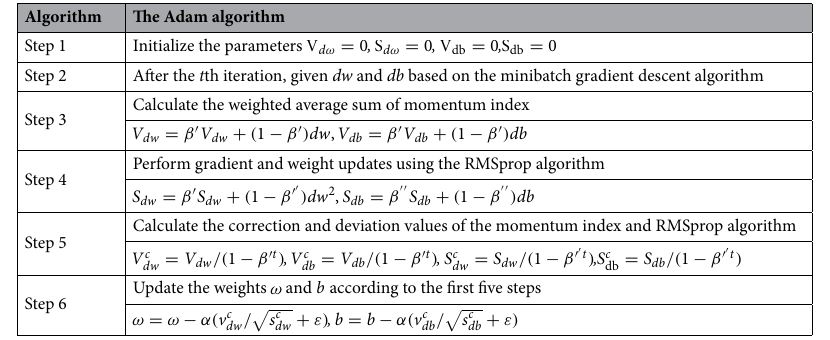
Table 3. Computing method of the Adam optimizer. where α is a factor controlling the learning rate of the network, β ′ is the exponential decay rate of the first-order moment estimate, β ′′ is the exponential decay rate of the second-order moment estimate, and ε is a constant that tends to zero infinitely as the